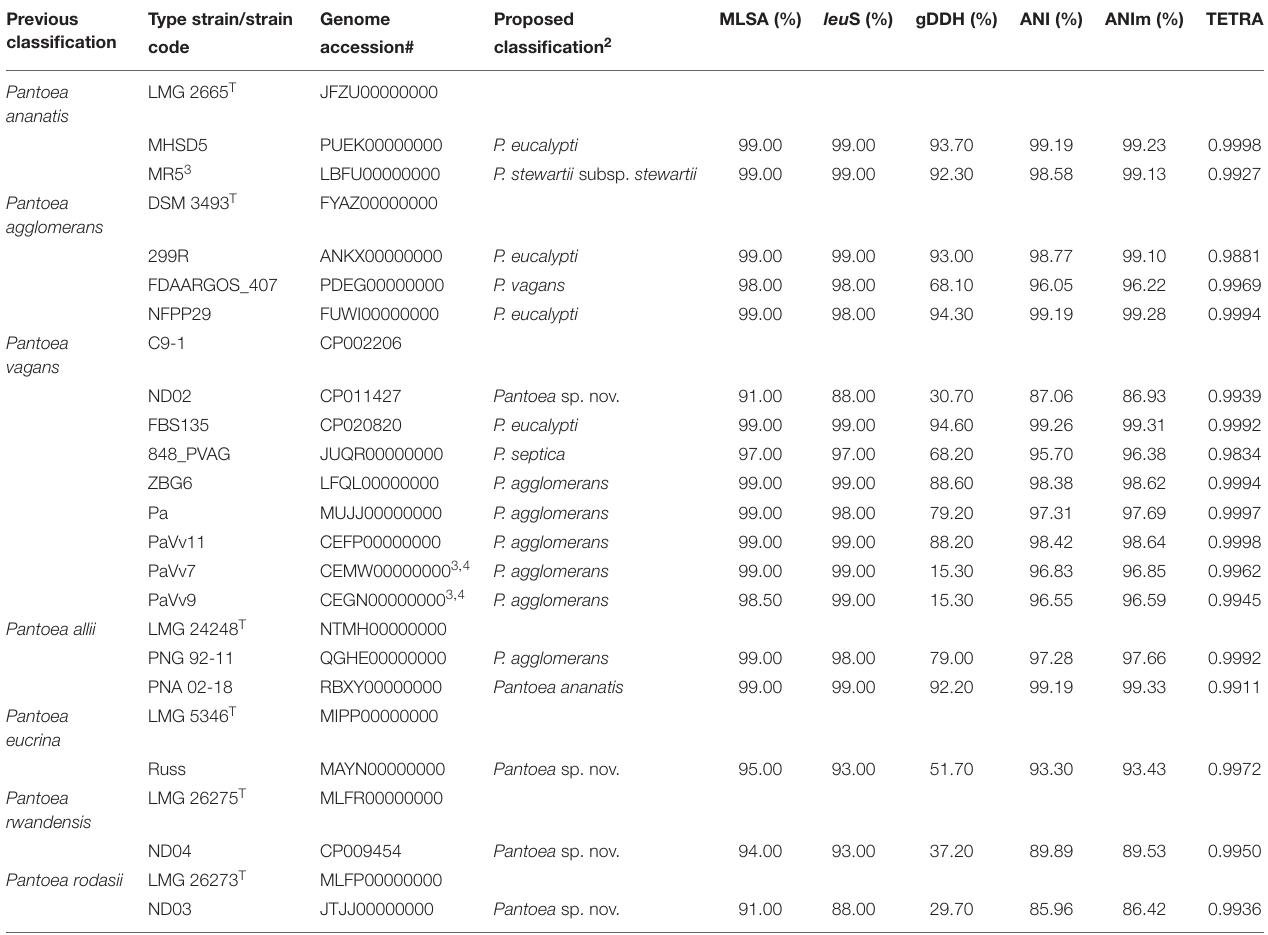
TABLE 1 | Proposed taxonomic affiliations based on concatenated MLSA, leu S, and whole-genome indices of genome sequences incorrectly assigned at the species level 1 . Previous